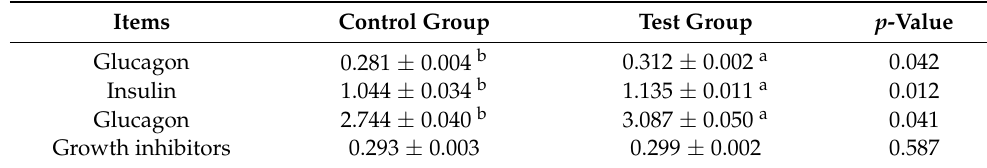
Table 8. Effect of concentrate supplementation on pancreatic hormone content in yak calves (Unit: Ug/L).